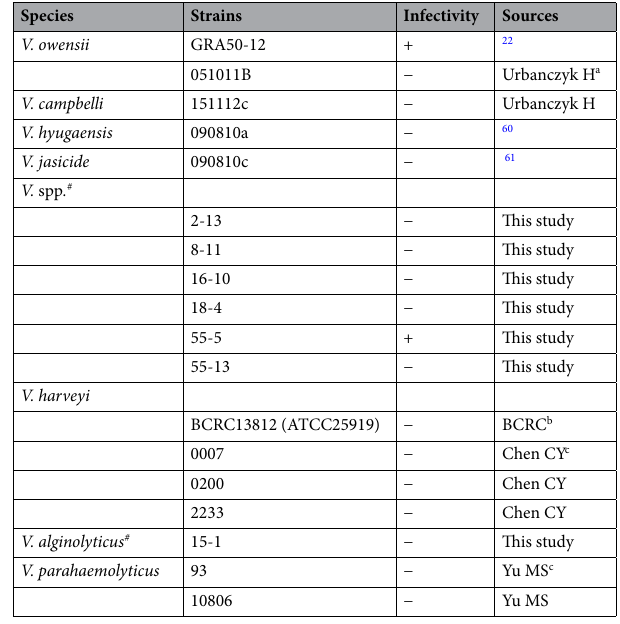
Table 1. Host range of phi50-12 against Vibrio spp. in this study. a University of Miyazaki, Miyazaki, Japan; b Bioresource Collection and Research Center, Taiwan; c Tzu Chi University, Hualien, Taiwan, # Identification by selective medium TCBS and 16S rRNA sequencing.